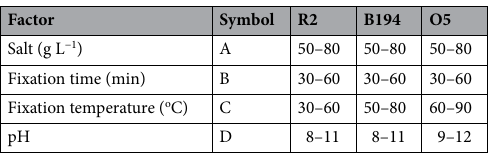
Table 1. L16 (4^4) orthogonal experimental scheme for exhaust dyeing.